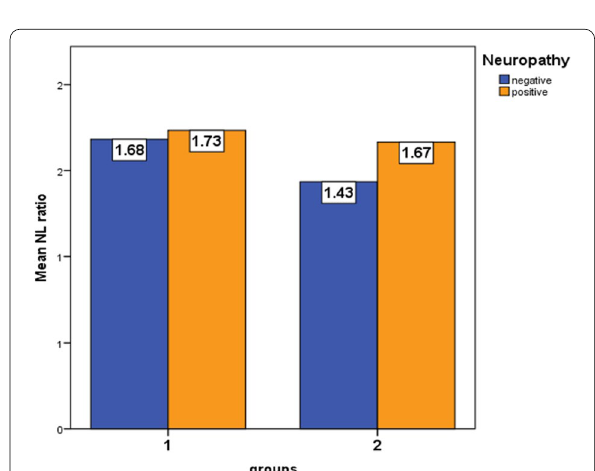
Fig. 2 The difference in the mean value of NLR in geriatric patients screened for neuropathy in Group 1 (T2DM with hypertension) and Group 2 (only T2DM) individually